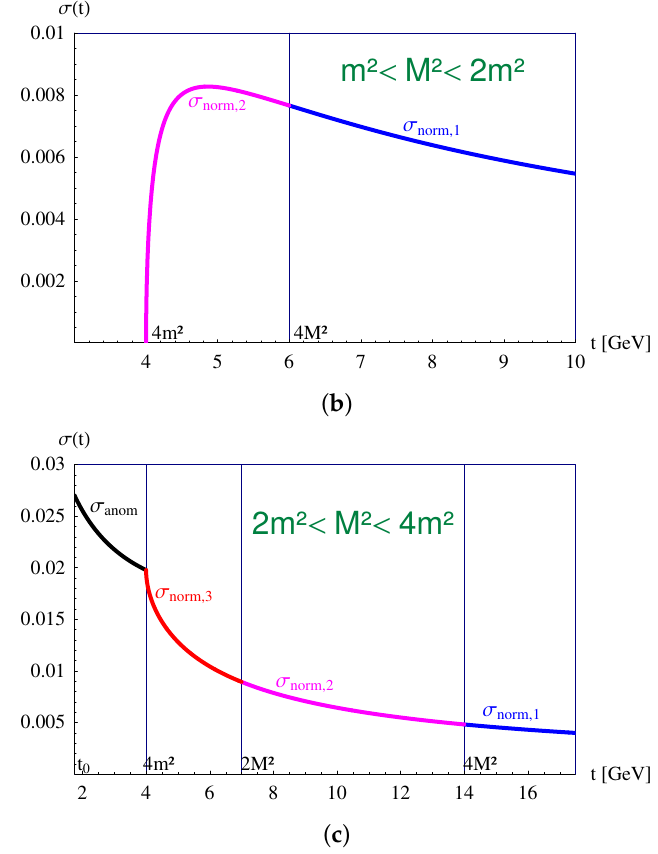
Figure 5. The spectral density σ ( t , M 2 ) for different values of m and M . ( a ) M 2 < m 2 ; ( b ) m 2 < M 2 < 2 m 2 ; ( c ) 2 m 2 < M 2 < 4 m 2 . σ norm,1 (blue line) corresponds to the analytic expression in the first line of Equation (16); σ norm,2 (magenta line) corresponds to the analytic expression in the second line of Equation (16); and σ norm,3 (red line) corresponds to the analytic expression in the third line of Equation (16). σ anom (black line) is given by Equation (17). Notice that, for M 2 < 2 m 2 , plots (a) and (b), the spectral density vanishes at the normal threshold t = 4 m 2 , whereas, in the case M 2 > 2 m 2 , plot (c), the spectral density does not vanish neither at the normal threshold 4 m 2 , nor at the anomalous threshold t 0 .